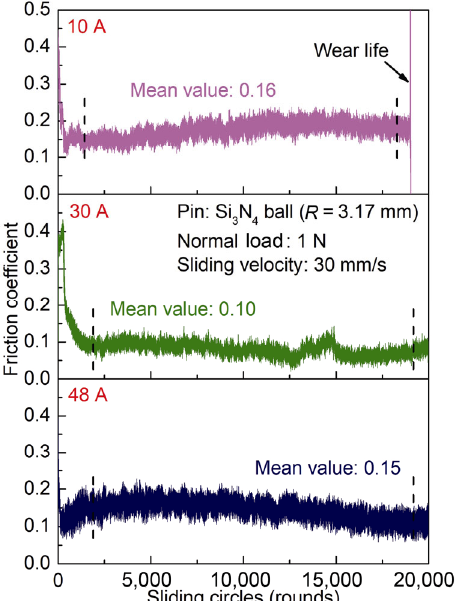
Fig. 6 Optical images of the Si 3 N 4 ball surfaces sliding against the carbon films. (a–c) Surfaces at different rounds when sliding against a film with I s of 10 A; (d–f) surfaces at different rounds when sliding against the film with I s of 30 A; and (g–i) surfaces at different rounds when sliding against the film with I of 48 s